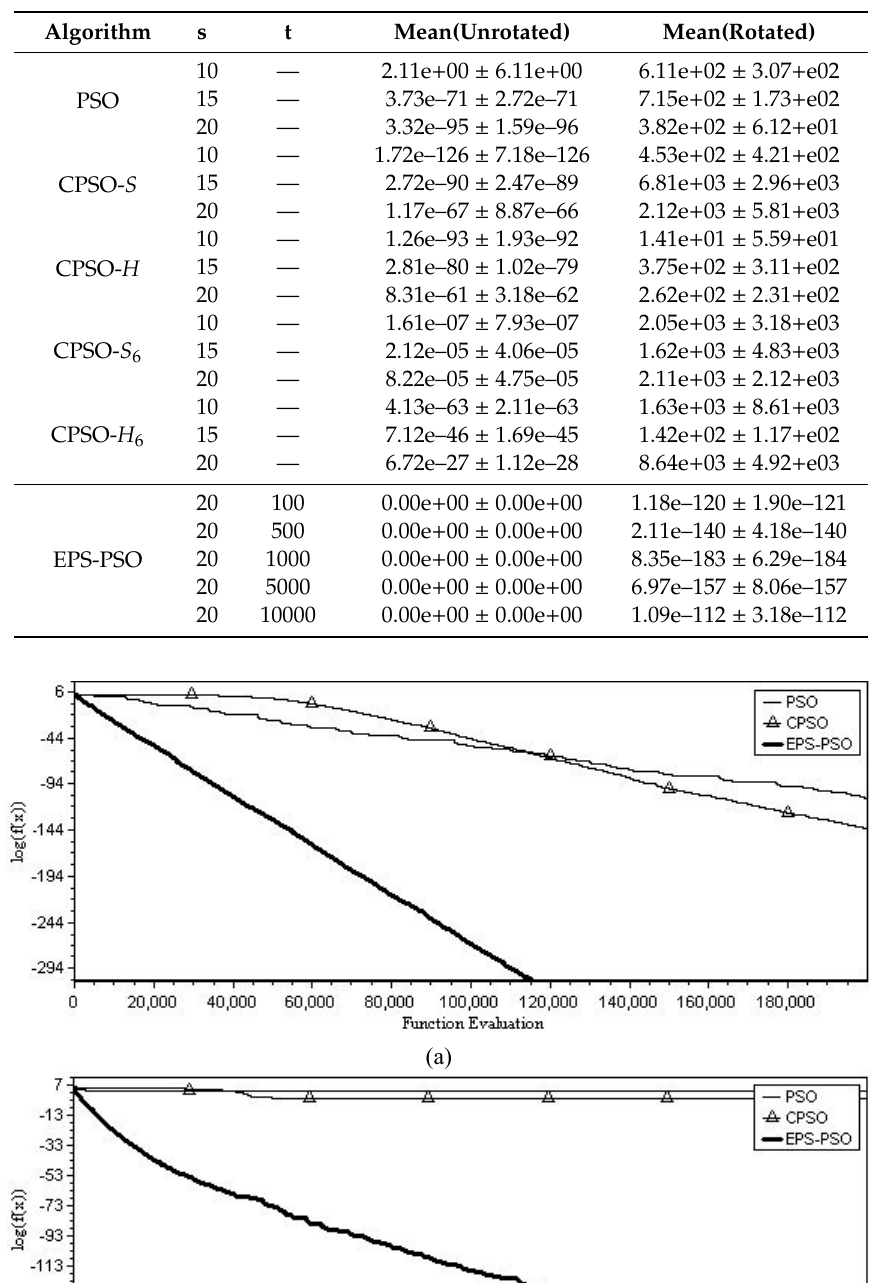
Table 3. Computational results of Quadric obtained by using 6 PSO-based algorithms after 2 × 10 5 function evaluations, averaged over 50 independent runs.